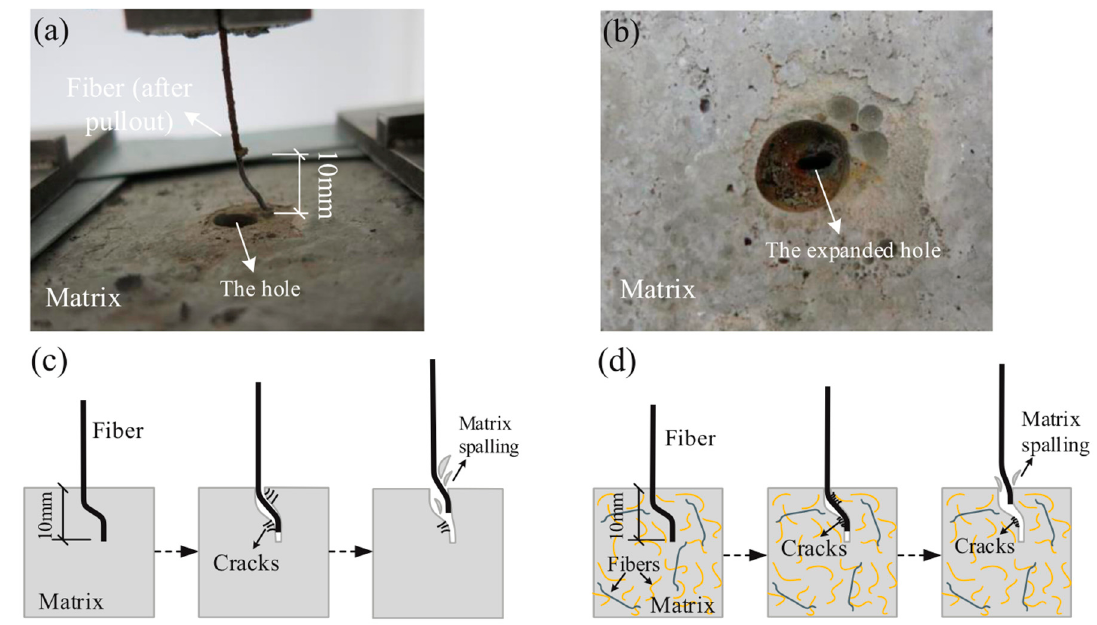
Figure 14. The modes of failure in pull-out test: ( a ) Matrix surface ( b ) after fibre pull-out; and fibre pull-out failure mechanism in the matrix ( c ) without and ( d ) with fibres [11].